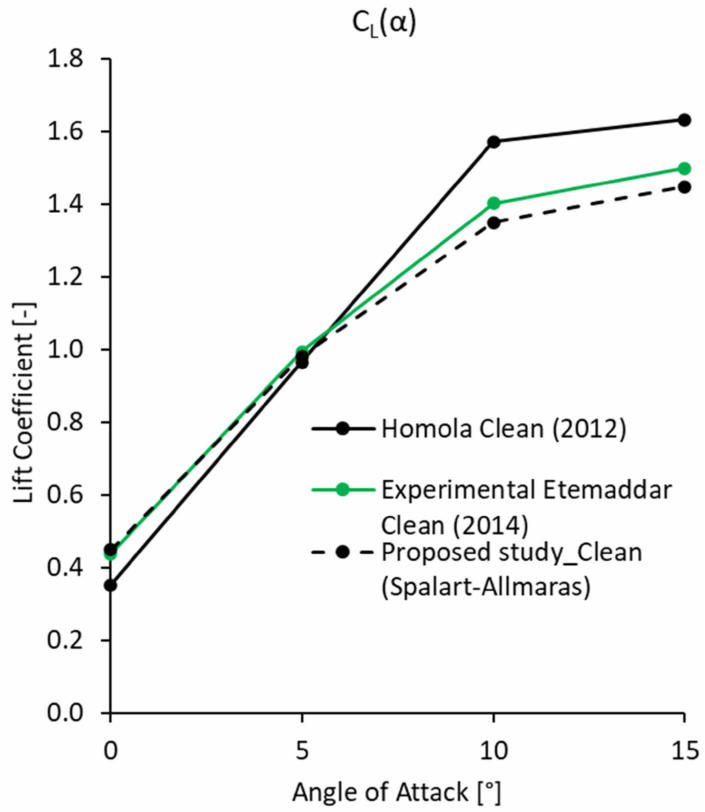
Figure 4. Lift coefficient for the clean airfoil compared with [10,25].